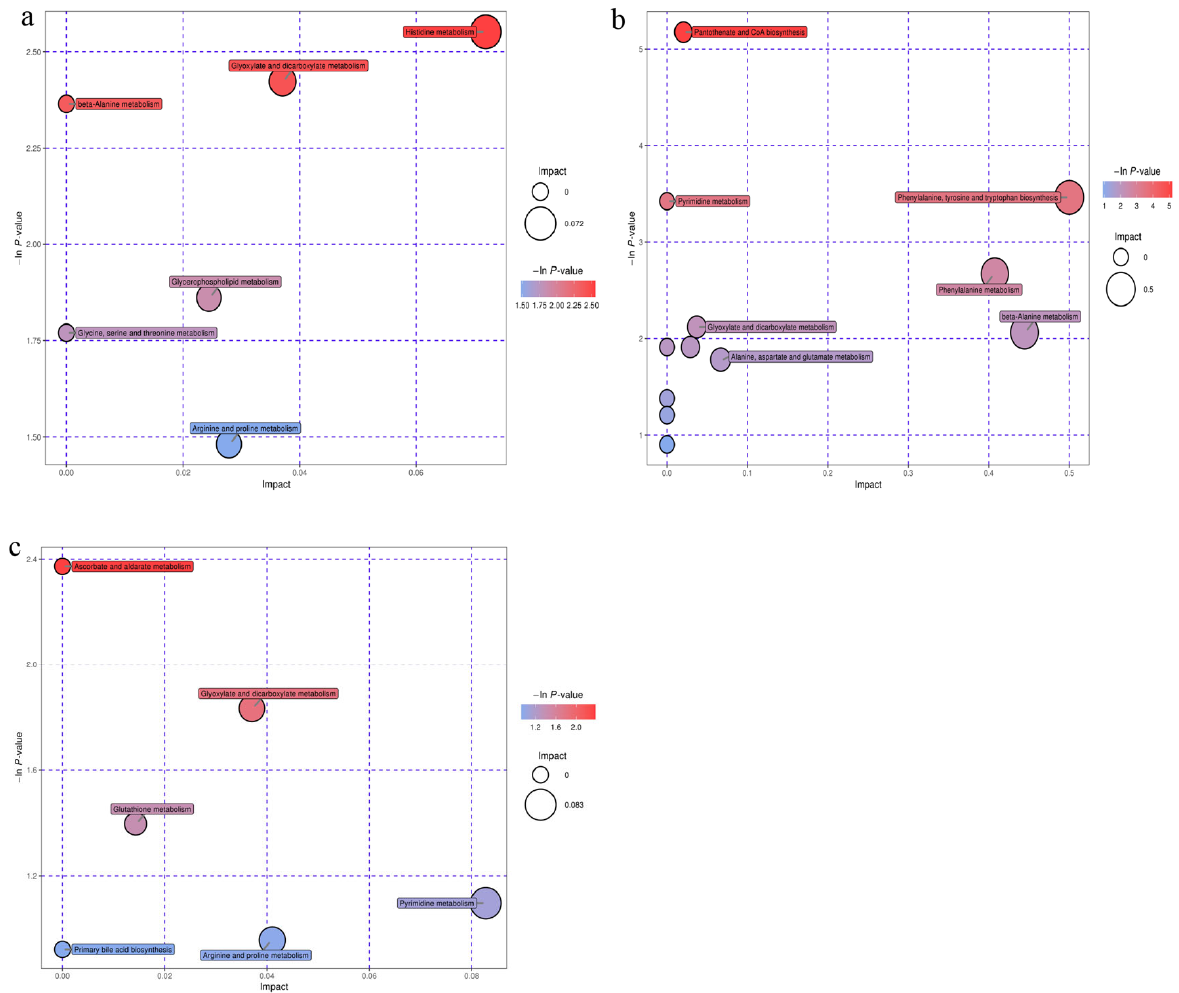
Figure 5. Pathway (each bubble represents a pathway) analysis of potential metabolite biomarkers. The larger the bubble, the larger the impact value; the darker the color of the bubble, the smaller the p ‐ value: ( a ), Angelica sinensis group; ( b ), Codonopsis pilosula group; ( c ), Glycyrrhiza uralensis group. Compared to control calves, calves consuming root extract of A. sinensis down- regulated the biomarkers of choline in the metabolite pathways of glycine, serine, threonine, and glycerophospholipid; and up-regulated methylimidazole in histidine metabolism, gly- colate in glyoxylate and dicarboxylate metabolism, citrulline in arginine biosynthesis, and anserine in β -alanine metabolism (Figure 6a). Root extract of C. pilosula down-regulated the biomarkers of l-phenylalanine in phenylalanine, tyrosine and tryptophan biosynthesis, phenylalanine in phenylalanine metabolism, pantothenate and β -alanine in pantothenate and CoA biosynthesis, 4-acetamidobutanoic acid in arginine and proline metabolism, and deoxythymidylic acid (dTMP) and thymidine in pyrimidine metabolism; and up-regulated succinic acid semialdehyde in butanoate metabolism, and glycolic acid in glyoxylate and dicarboxylate metabolism (Figure 6b). Root extract of G. uralensis down-regulated deoxyuri- dine monophosphate (dUMP) in pyrimidine metabolism and cholic acid and primary bile acids in primary bile acid biosynthesis; and up-regulated 5-oxoproline in glutathione metabolism, 4-hydroxyproline in arginine and proline metabolism, glycolic acid in glyoxy- late and dicarboxylate metabolism, and L-gulonol-1,4-lactone in ascorbate and aldarate metabolism (Figure